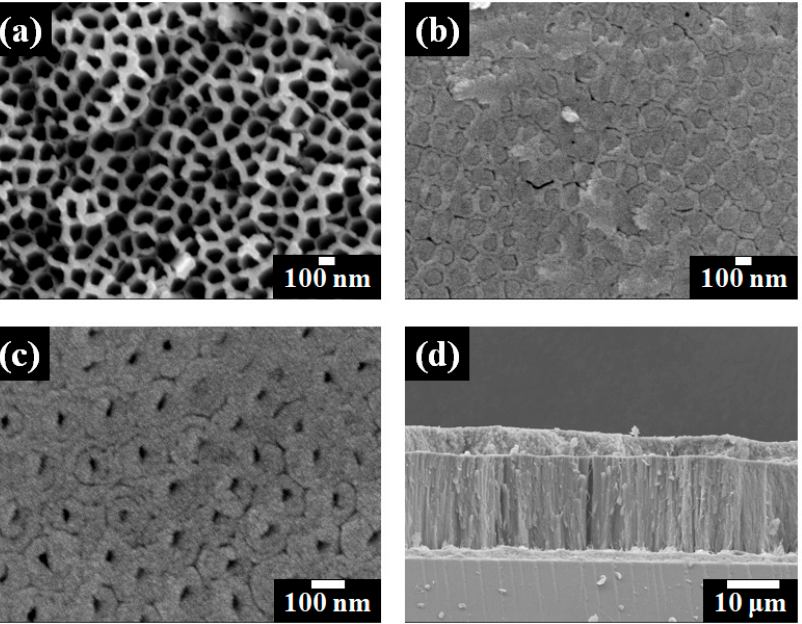
Figure 2. Field emission scanning electron microscope (FE-SEM) images of freestanding TiO 2 nanotube arrays. ( a ) Top view; ( b ) Bottom view before ion milling process; ( c ) Bottom view after ion milling process of freestanding TiO 2 nanotube arrays; and ( d ) Side view of freestanding TiO 2 nanotube arrays and large TiO 2 NPs on the fluorine-doped tin oxide (FTO) glass.